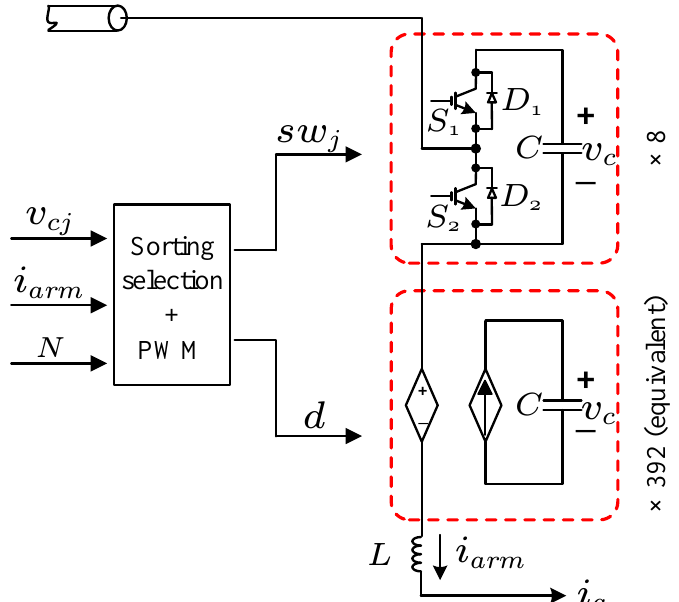
Figure 15. A hybrid approach of modeling an MMC arm by the combination of average and switching